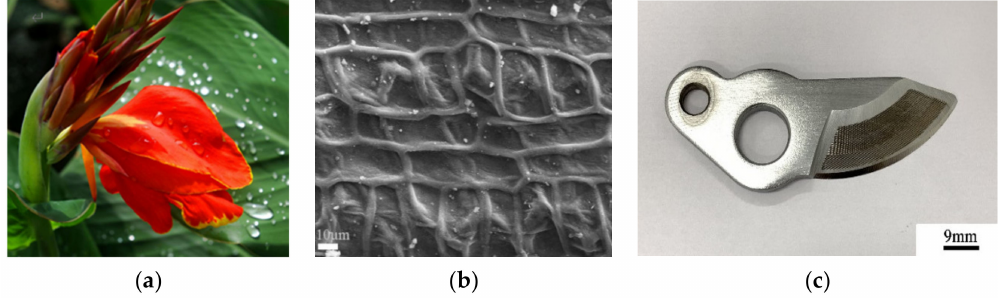
Figure 9. Canna leaf and Convex-hull textured pruner: ( a ) Canna leaf; ( b ) enlarged structure of Canna leaf; ( c ) convex-hull textured pruner. (Laser power: 70 W, scanning speed: 3.2 mm / s).